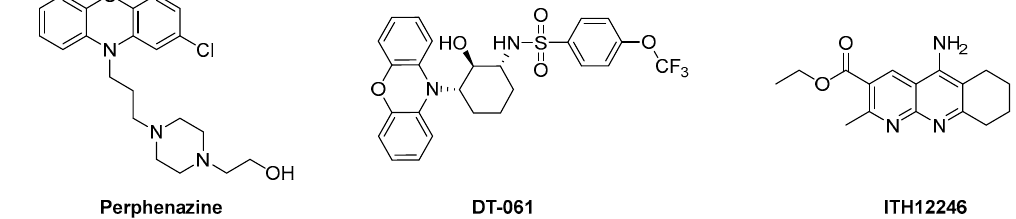
Figure 8. Chemical structure of selected direct PADs.